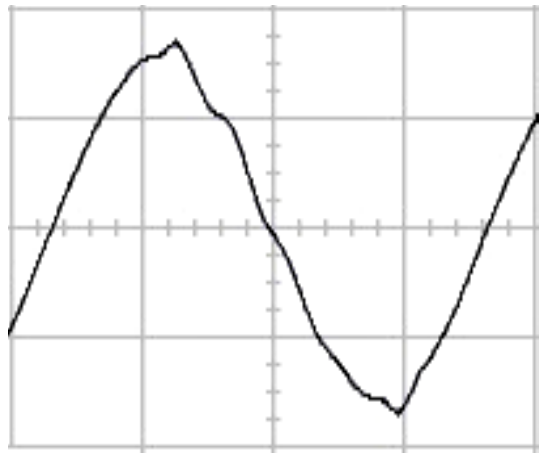
Figure 16. Experimental AC output voltage for the traditional SMRL under a sudden removal of load (vertical: 100 V/div and 5 ms/div).